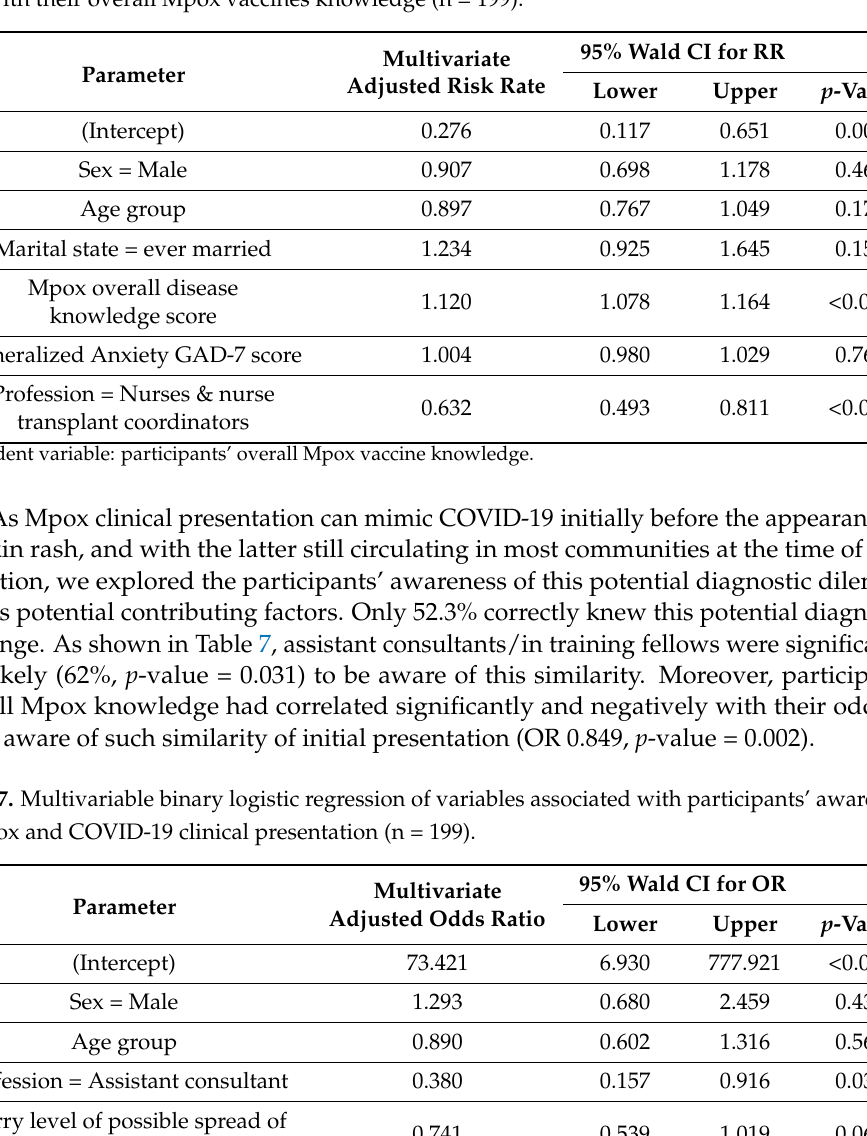
Table 6. Multivariate general Linear regression gamma analysis of the participants’ variables associ- ated with their overall Mpox vaccines knowledge (n = 199).